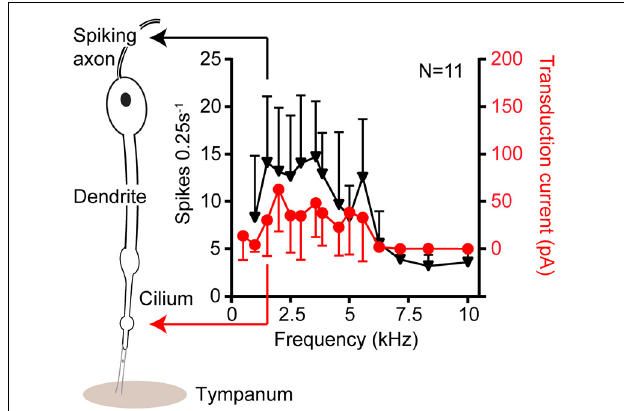
FIGURE 3 | Isolevel auditory tuning curves in response to 80 dB SPL from single auditory receptors of the locust ear. The black triangles are tuning curves derived from sound-induced axonal spikes at the neuron’s basal end. The red circles donate tuning curves based on the transduction current at the ciliated apical end. No change in the shape of the tuning curves suggesting no electrophysiological processes, like that of reptiles to, sharpen tuning in this insect